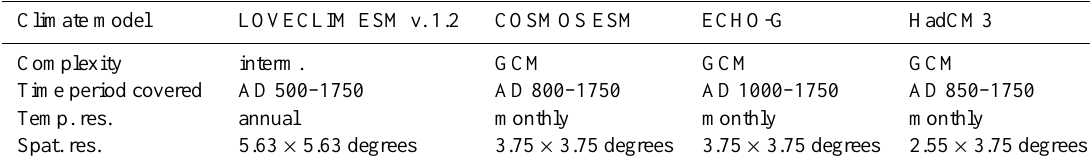
Table 1. Information on temperature from model experiments Climate model